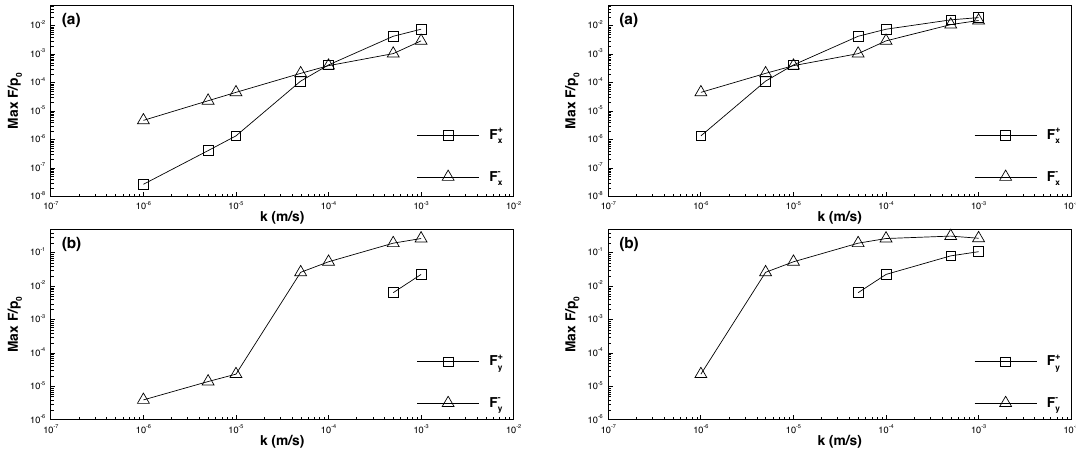
Figure 18. Maximum force on the pipeline in relation to soil permeability; left : E = 1.0 × 10 3 kPa; right : E = 1.0 × 10 4 kPa. ( a ) Horizontal component; ( b ) vertical component.